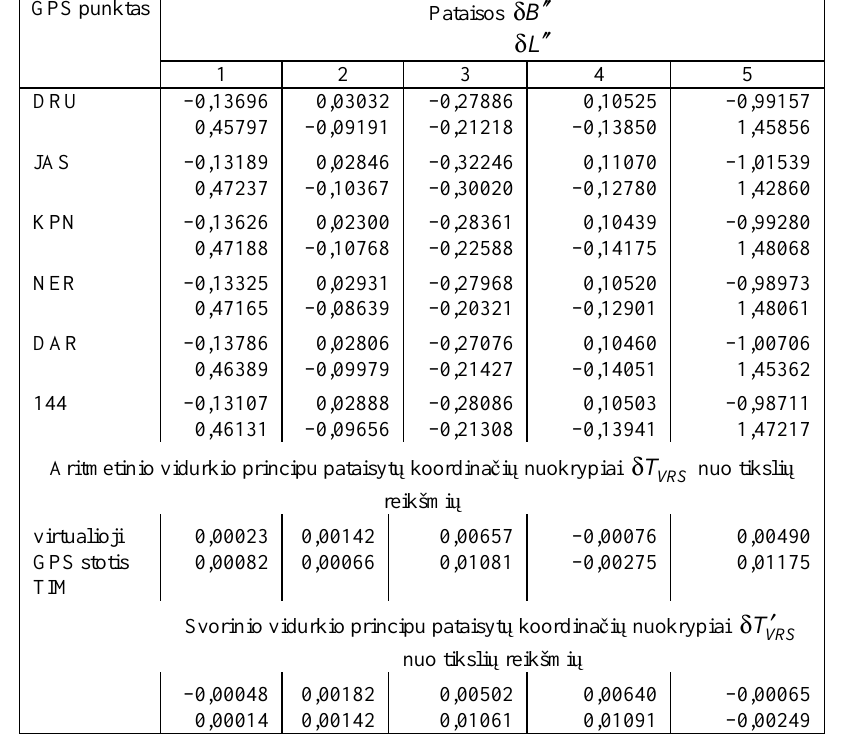
Table 1. Corrections of